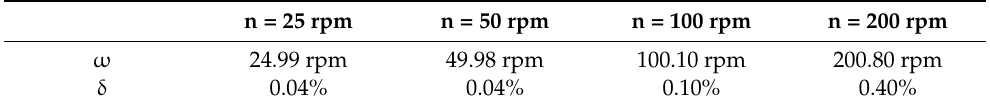
Table 1. The comparison data between different rotational speeds.